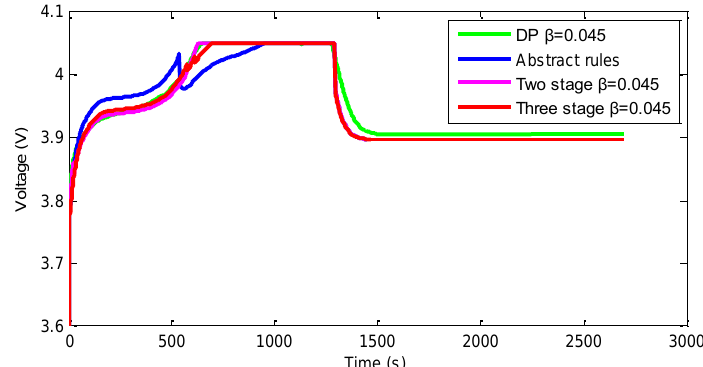
Figure 13. The terminal voltage comparison of three different methods.